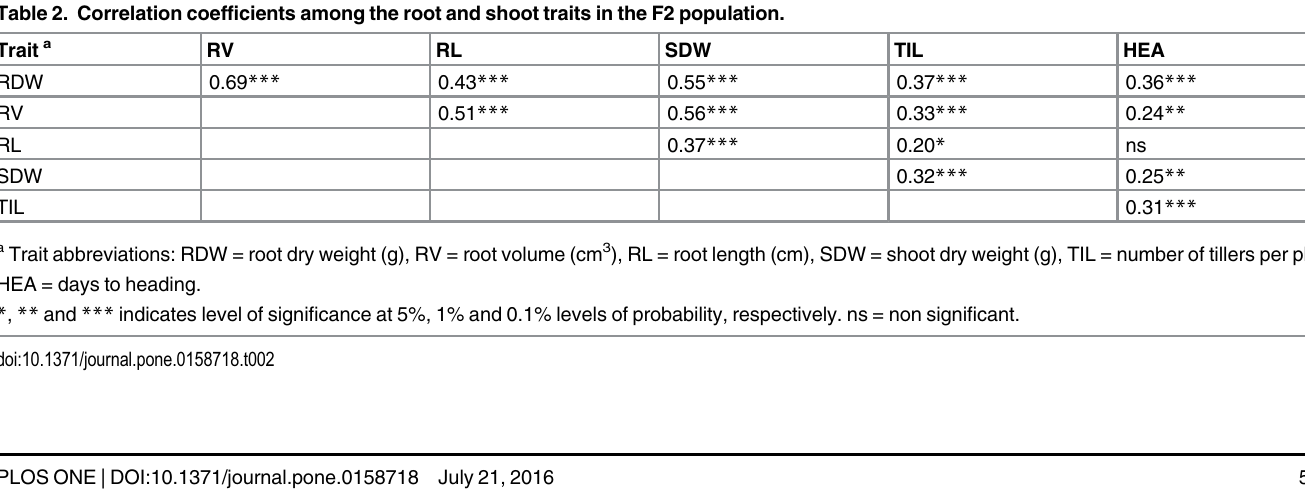
The correlation coefficients among the traits under drought conditions are presented in Table 2. RDW exhibited highly significant and positive correlations with SDW (0.55) and RL (0.43). RV revealed strong significant correlations with SDW (0.51) and RL (0.56). Among the shoot traits, TIL exhibited a positive and statistically significant correlation with SDW (0.32) and HEA (0.31).